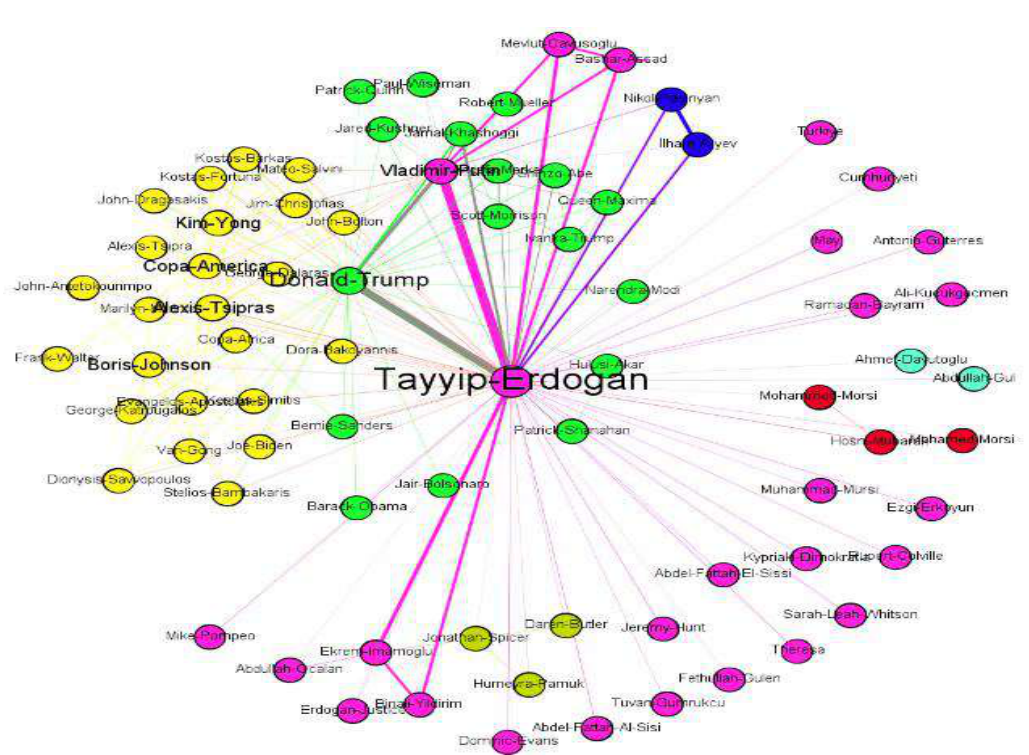
Figure 19: Modularity 2020 (Source: Authors ‟